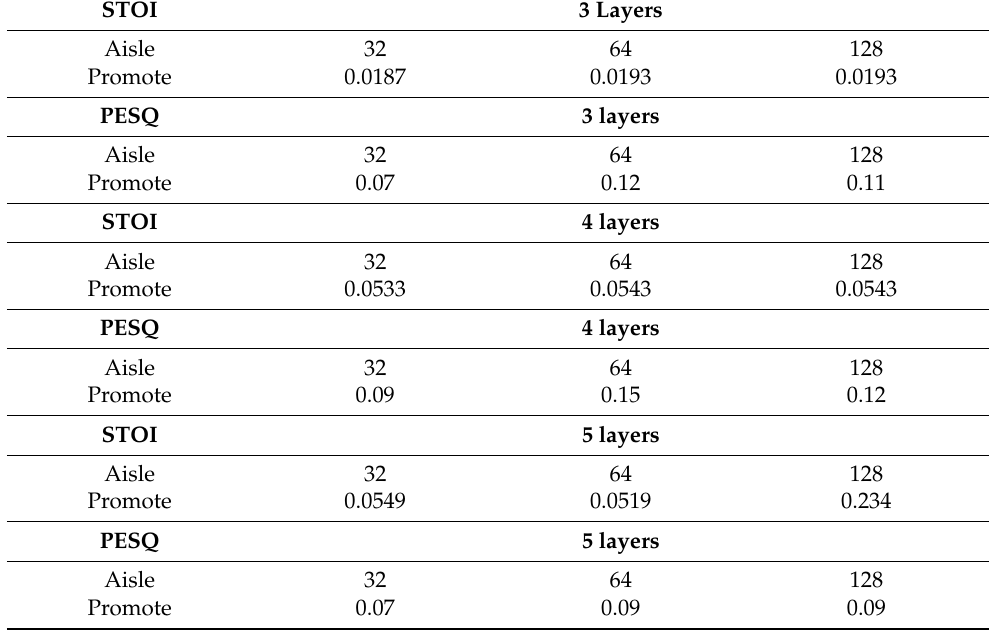
Table 7. Scoring of DNN Layer and Channel Selection.